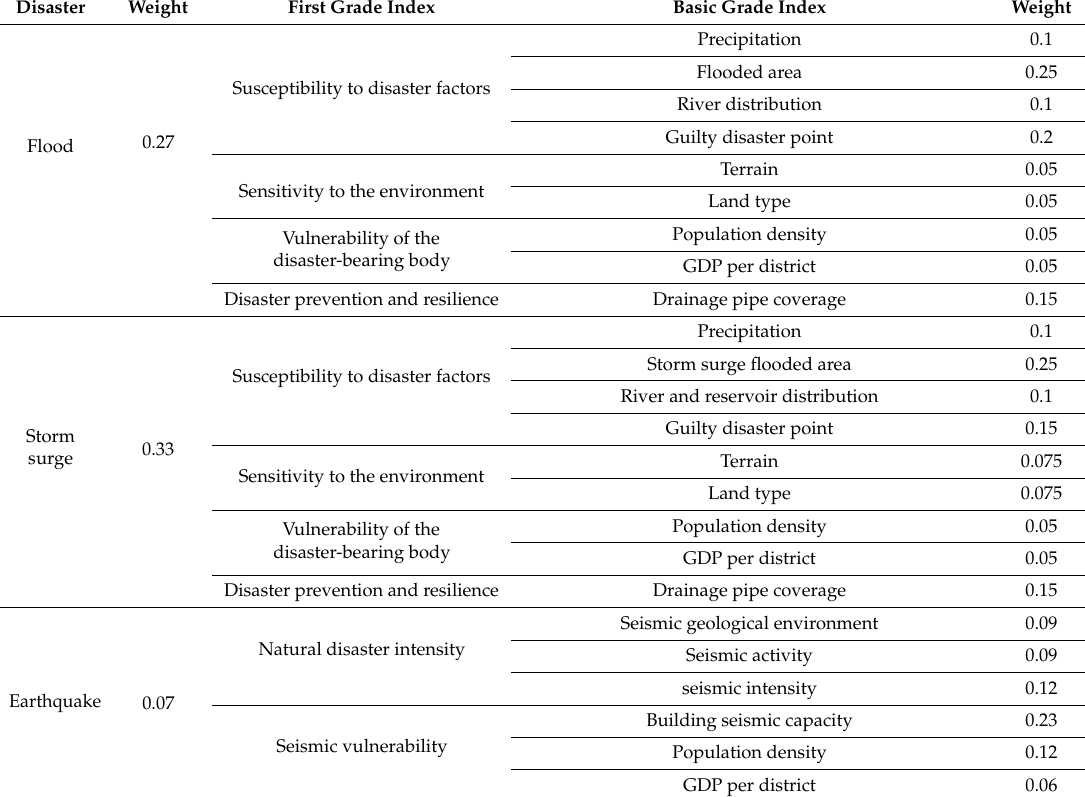
Table 2. Index system for evaluating the comprehensive disaster risk of